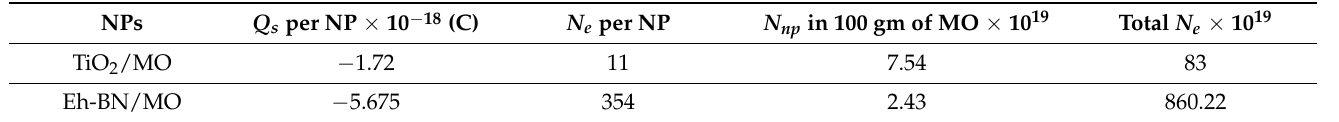
Table 7. Electron captures by the